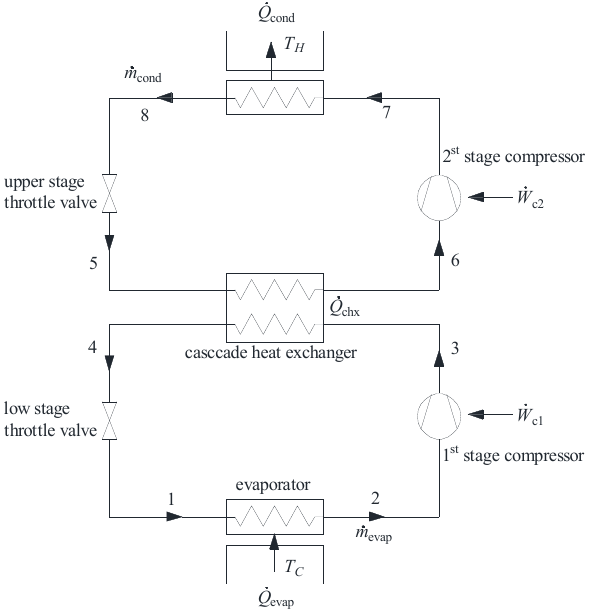
Figure 1. Principle of cascade heat pump system.